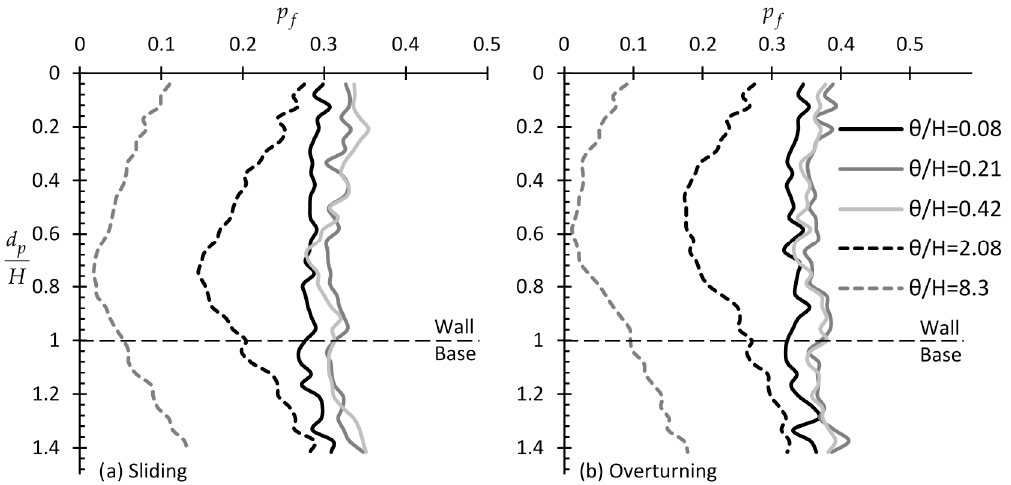
Figure 4. p f − d p / H curves for x / H = 0.5 and various θ / H values for the ( a ) smooth sliding and ( b ) smooth overturning mode of failure.